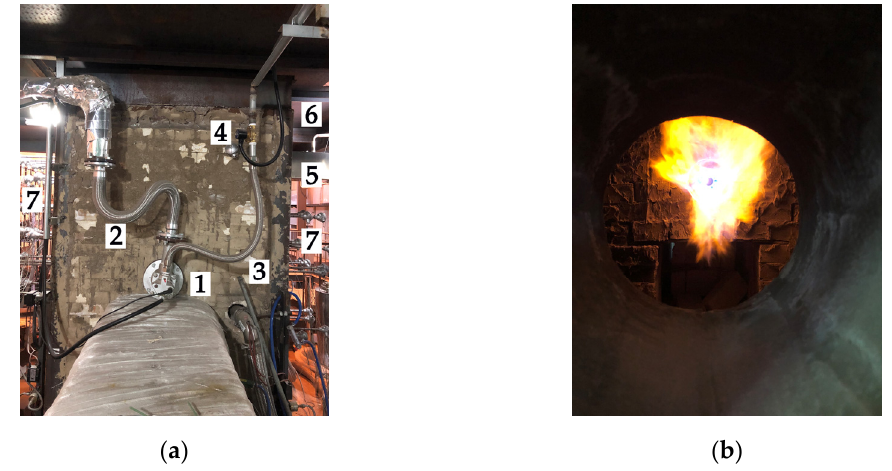
Figure 6. ( a ) Experiment facilities: (1) gas burner, (2) air line, (3) fuel line, (4) gas valve, (5) tail flue, (6) spray type attemperator (7) thermal couples; ( b ) resulting flame (observation hole is on the back wall, directly across the gas burner).